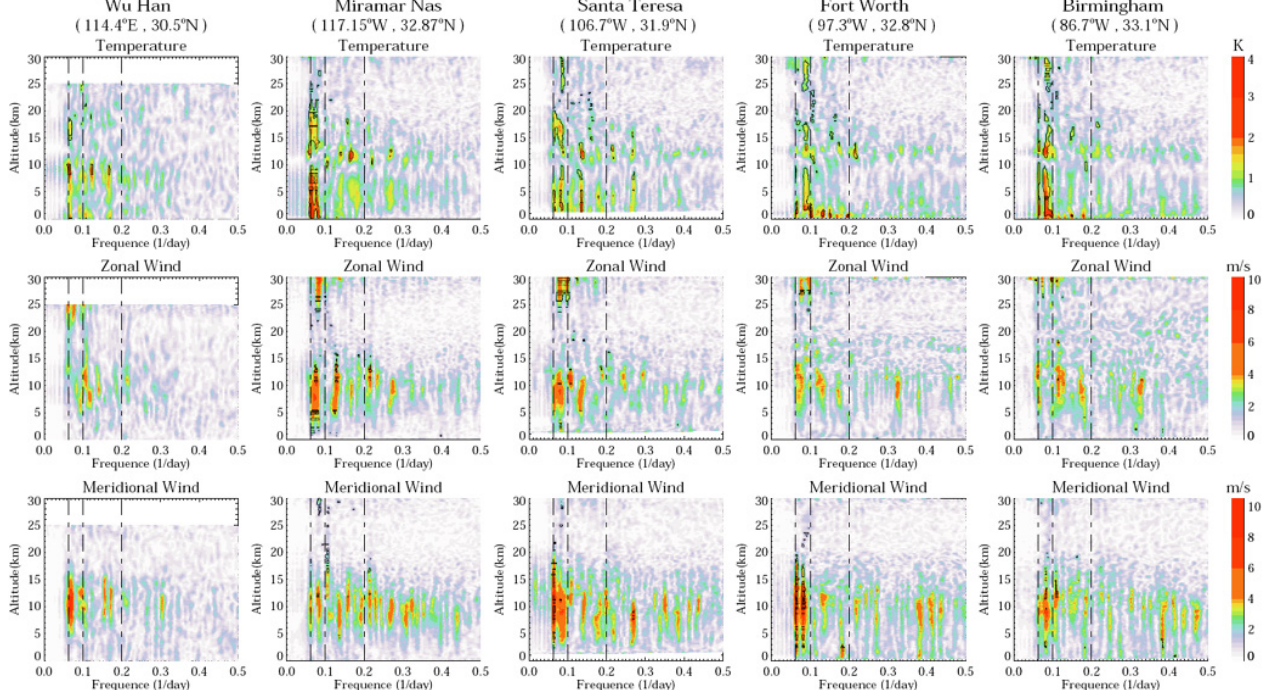
Fig. 6. The Lomb-Scargle spectral amplitudes of the temperature, zonal and meridional wind disturbances during December 2000 to Febru- ary 2001. The dash-dotted lines in every panel denote the frequencies of the 16-, 10-, and 5-day waves, respectively, from left to right. The significance of 90% confidence level is shown with black